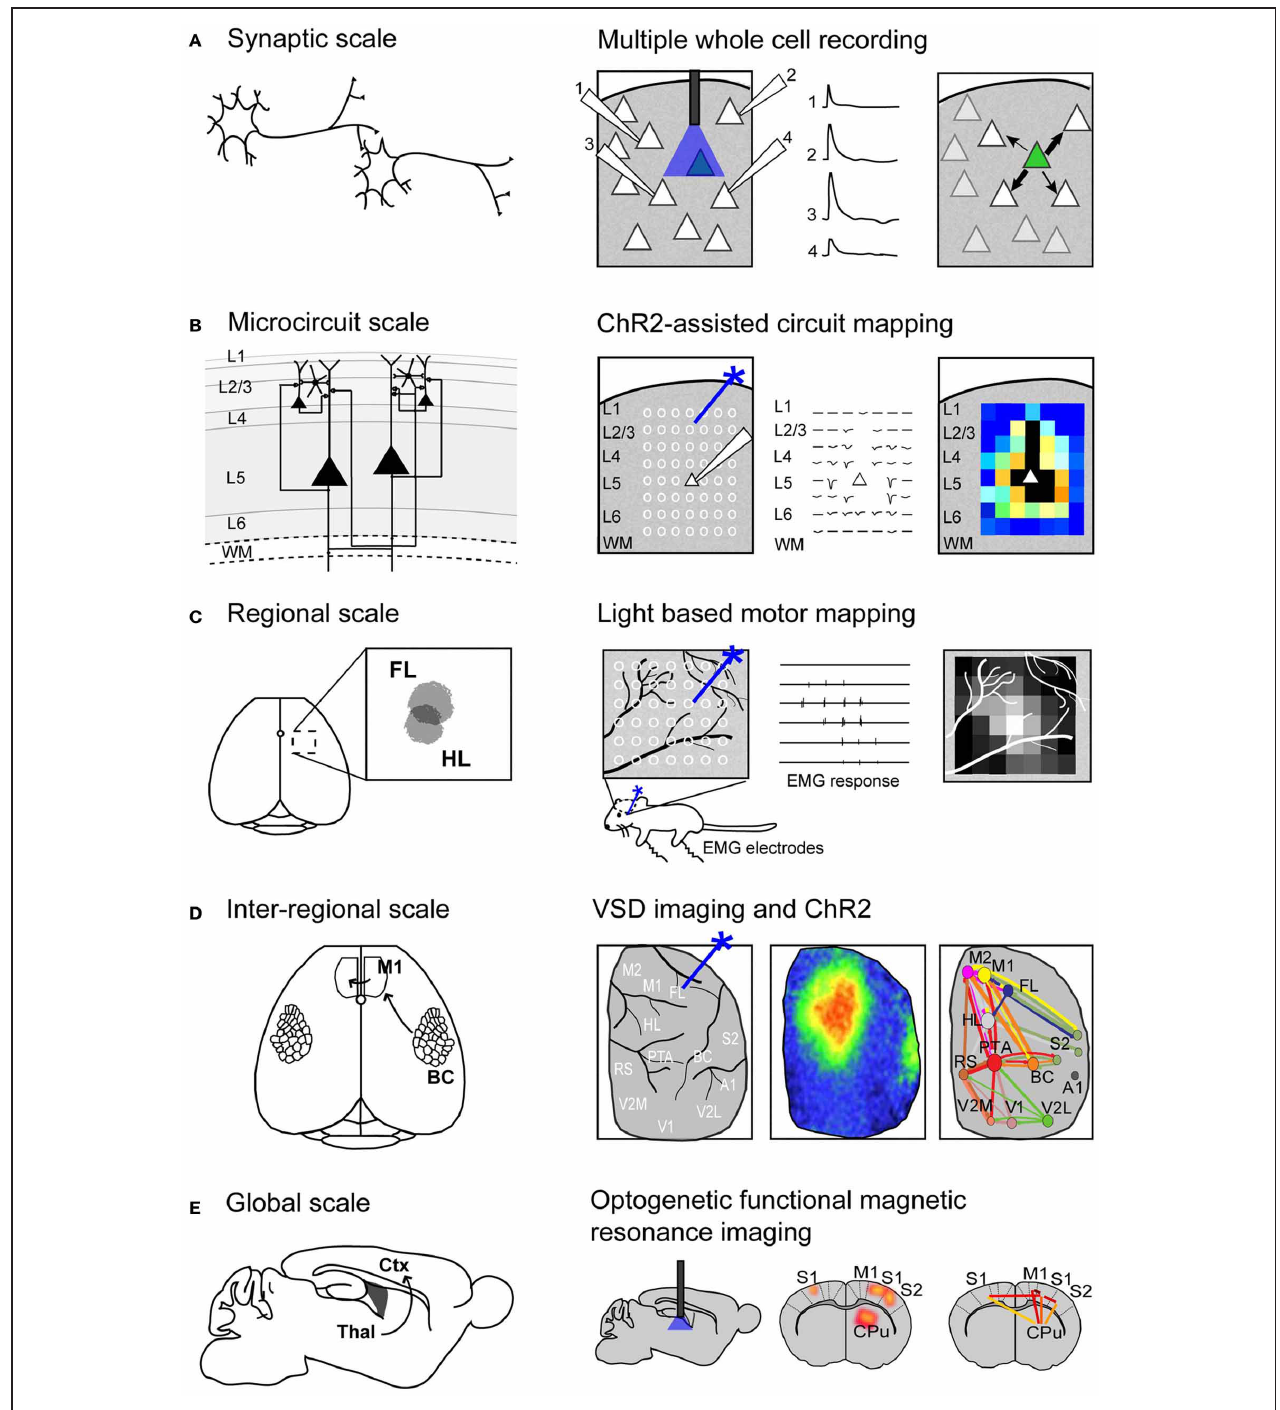
photostimulated (indicated by white circles) and the response is recorded from a single target neuron (white triangle). L, layer; WM, white matter. (C) Mapping functional connectivity within a region of cortex (left) using light-based motor mapping (right). A number of regions within the motor cortex are targeted for photostimulation (indicated by white circles) and the resulting motor responses are recorded through electromyograms (EMG) to determine function. FL, forelimb area of the sensorimotor cortex;